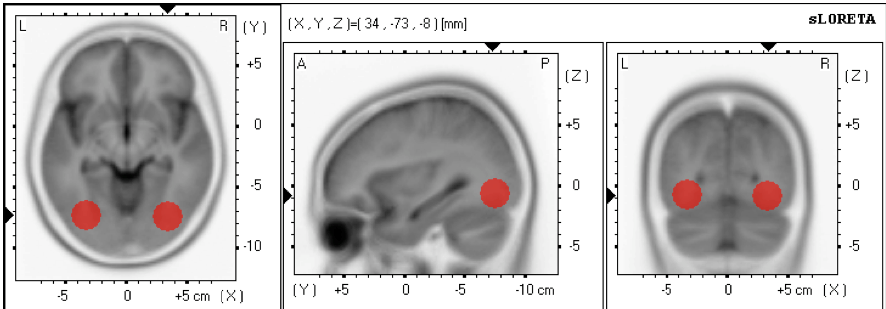
Figure 1. Selected ROIs in the right and left LOC for neurofeedback